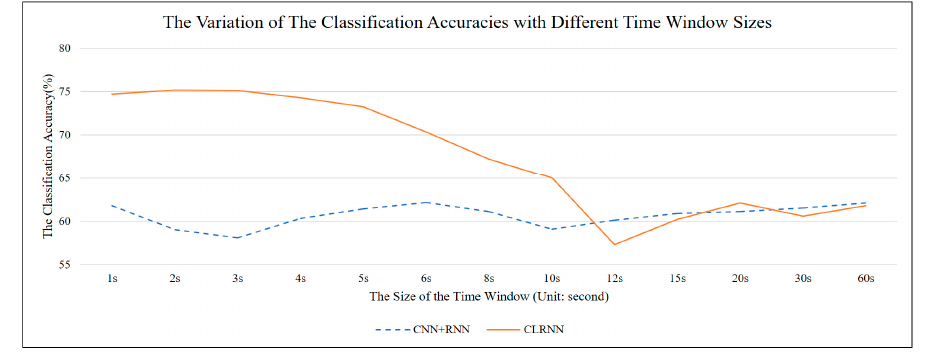
Figure 9. The comparison of the classification accuracies between CLRNN and CNN + RNN with different time window sizes.